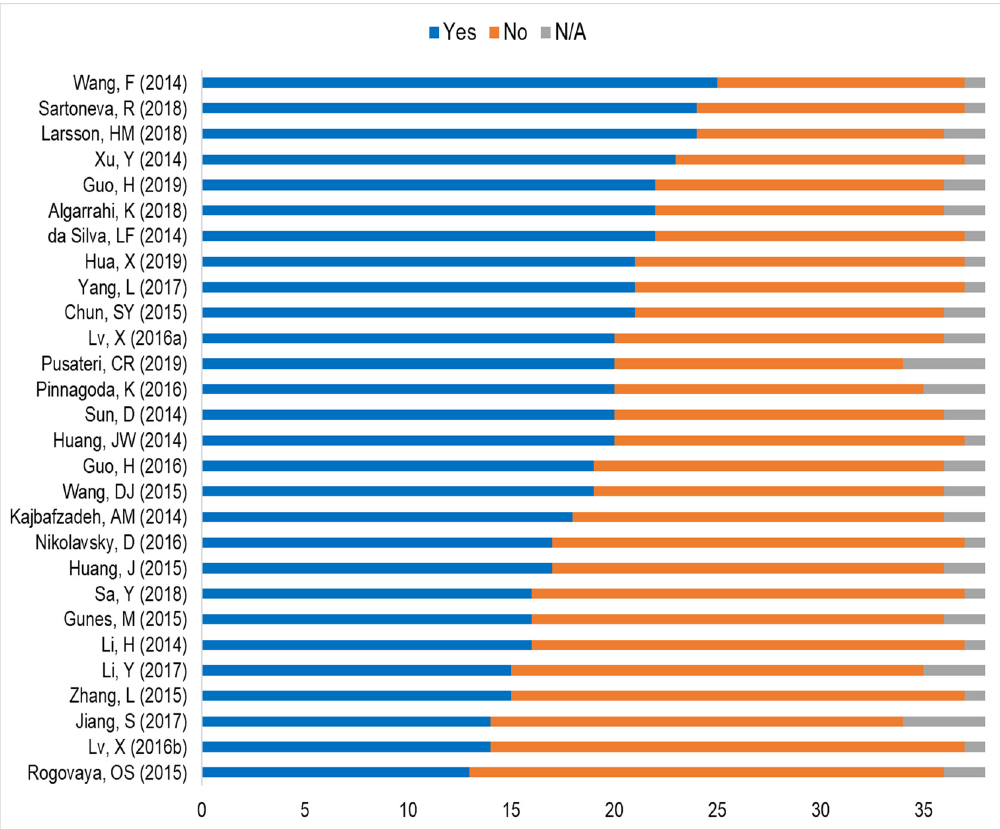
Figure 2. Bar chart displaying the frequencies of the options ‘Yes’, ‘No’, and ‘N/A’ among the 28 articles selected for the analysis.